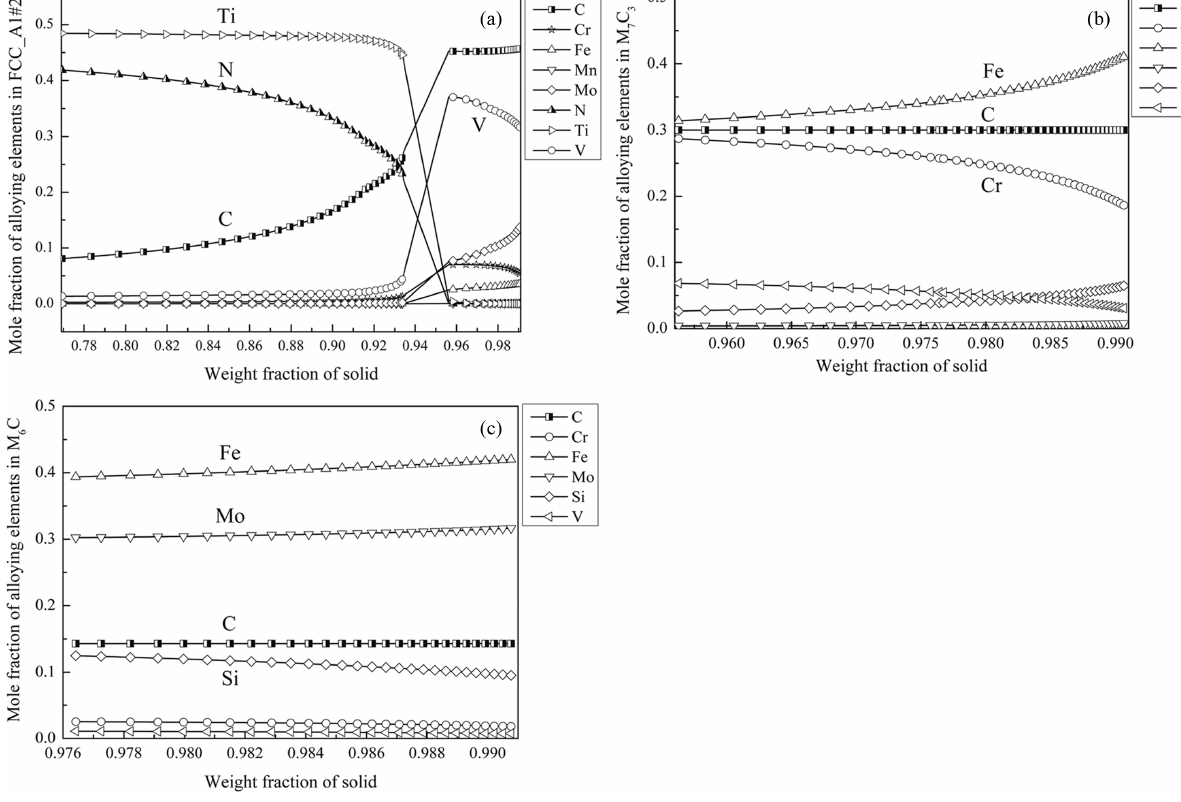
Figure 6: Mole fraction of alloying elements as a function of solid fraction, (a) FCC_A1#2, (b) M 7 C 3 , (c) M 6